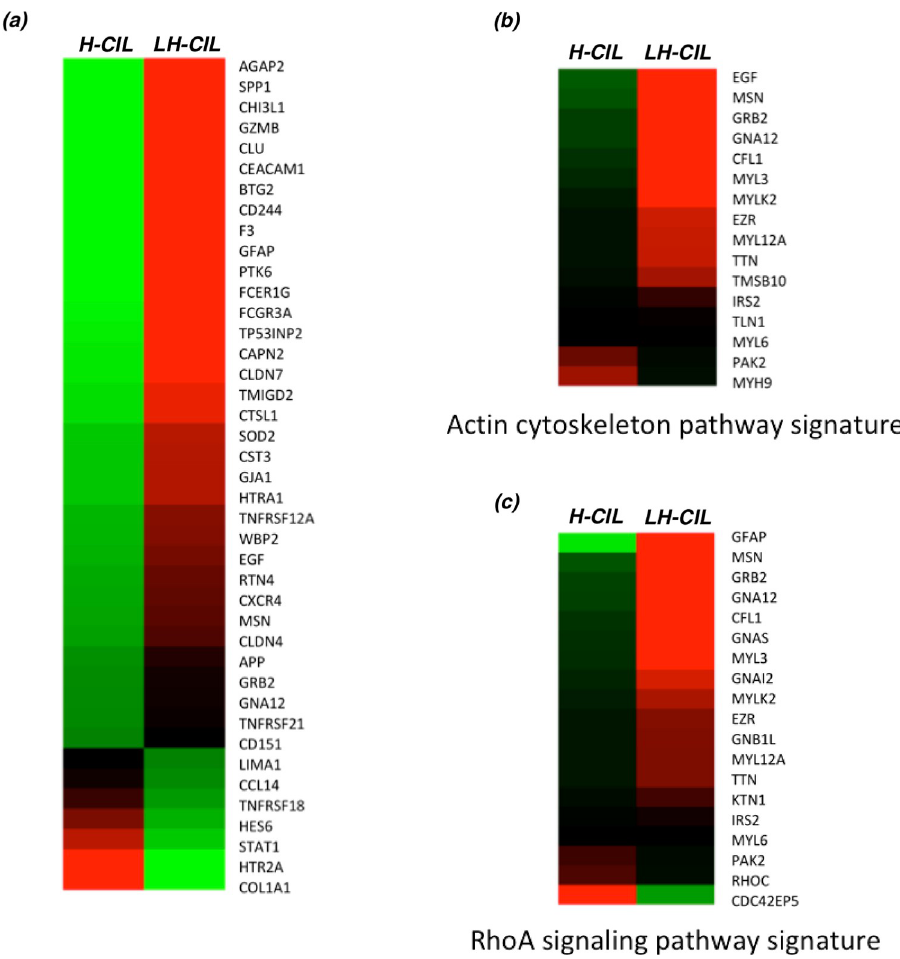
Fig 4. Gene expression